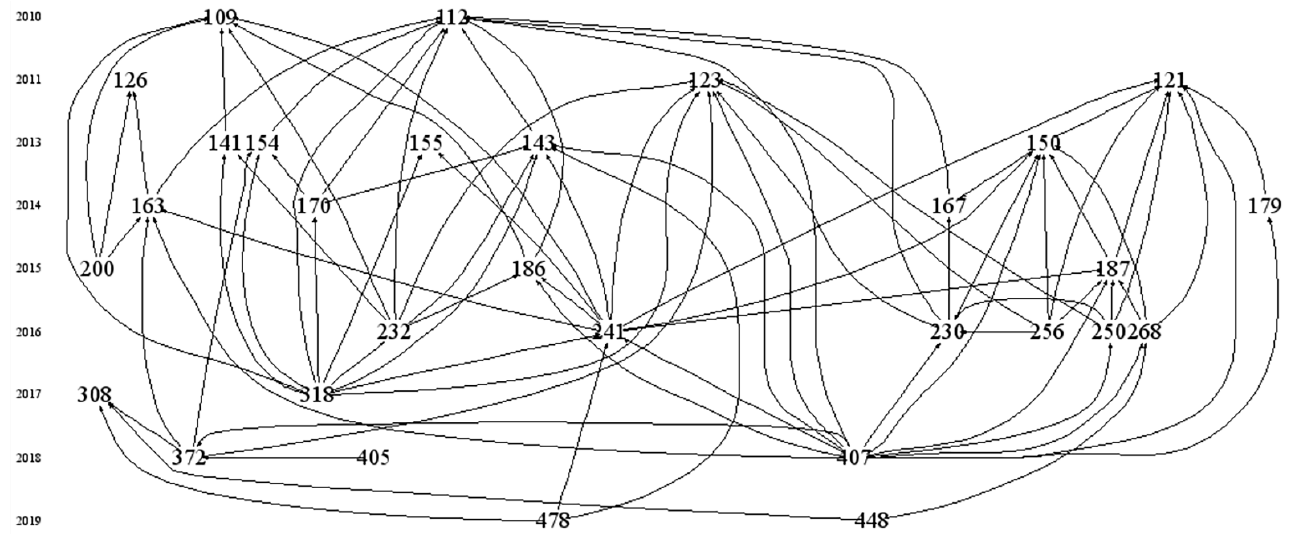
Figure 11. Evolution of the top 30 highly cited papers (by